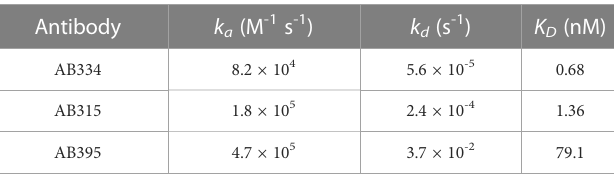
TABLE 1 Characteristics of NPNA3 peptide binding of mAbs chosen for making binary and ternary mixtures.